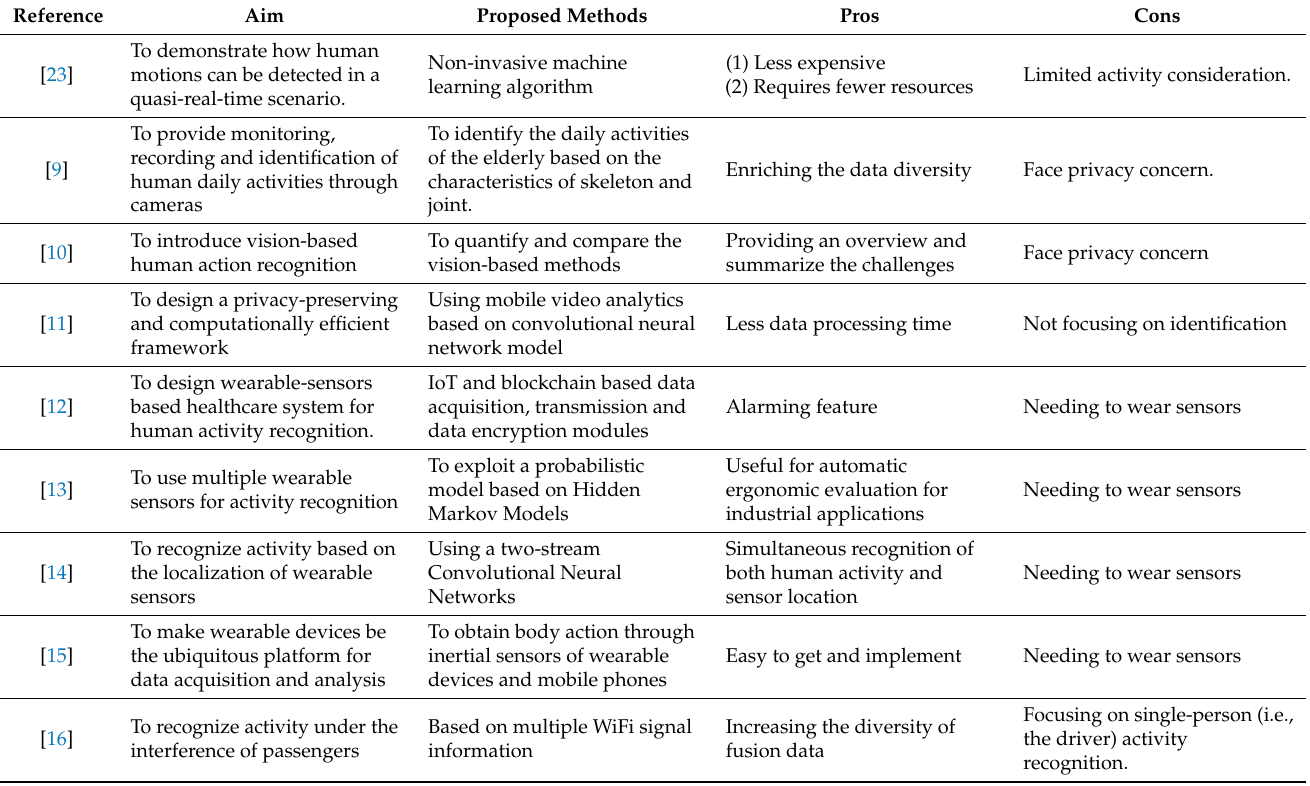
Table 1. Comparison of the literature for recognition.